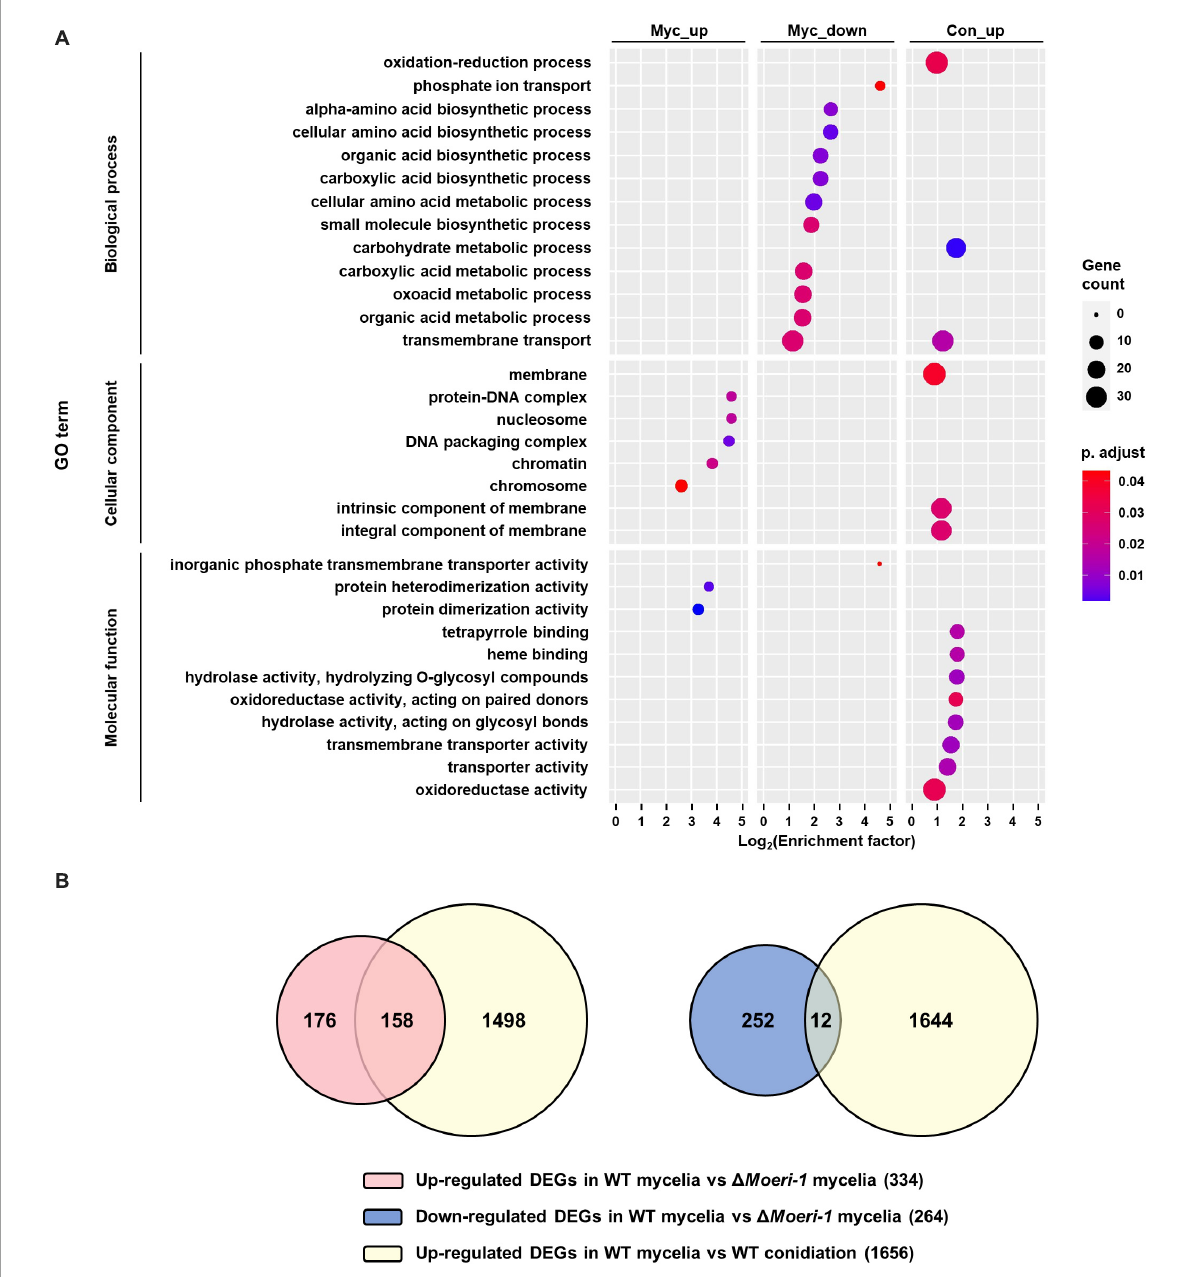
FIGURE7 DEG analyses between WT and (cid:49) Moeri-1 . (A) GO enrichment analysis was performed for DEGs in mycelia of WT and (cid:49) Moeri-1 , and during conidiation in WT with BLAST2GO (Conesa and Götz, 2008). Circle size denotes the number of enriched genes; circle color denotes the adjusted p -value; x -axis, enrichment factor. (B) Venn diagram between the DEGs by MoERI-1 deletion in mycelia and the up-DEGs during conidiation in